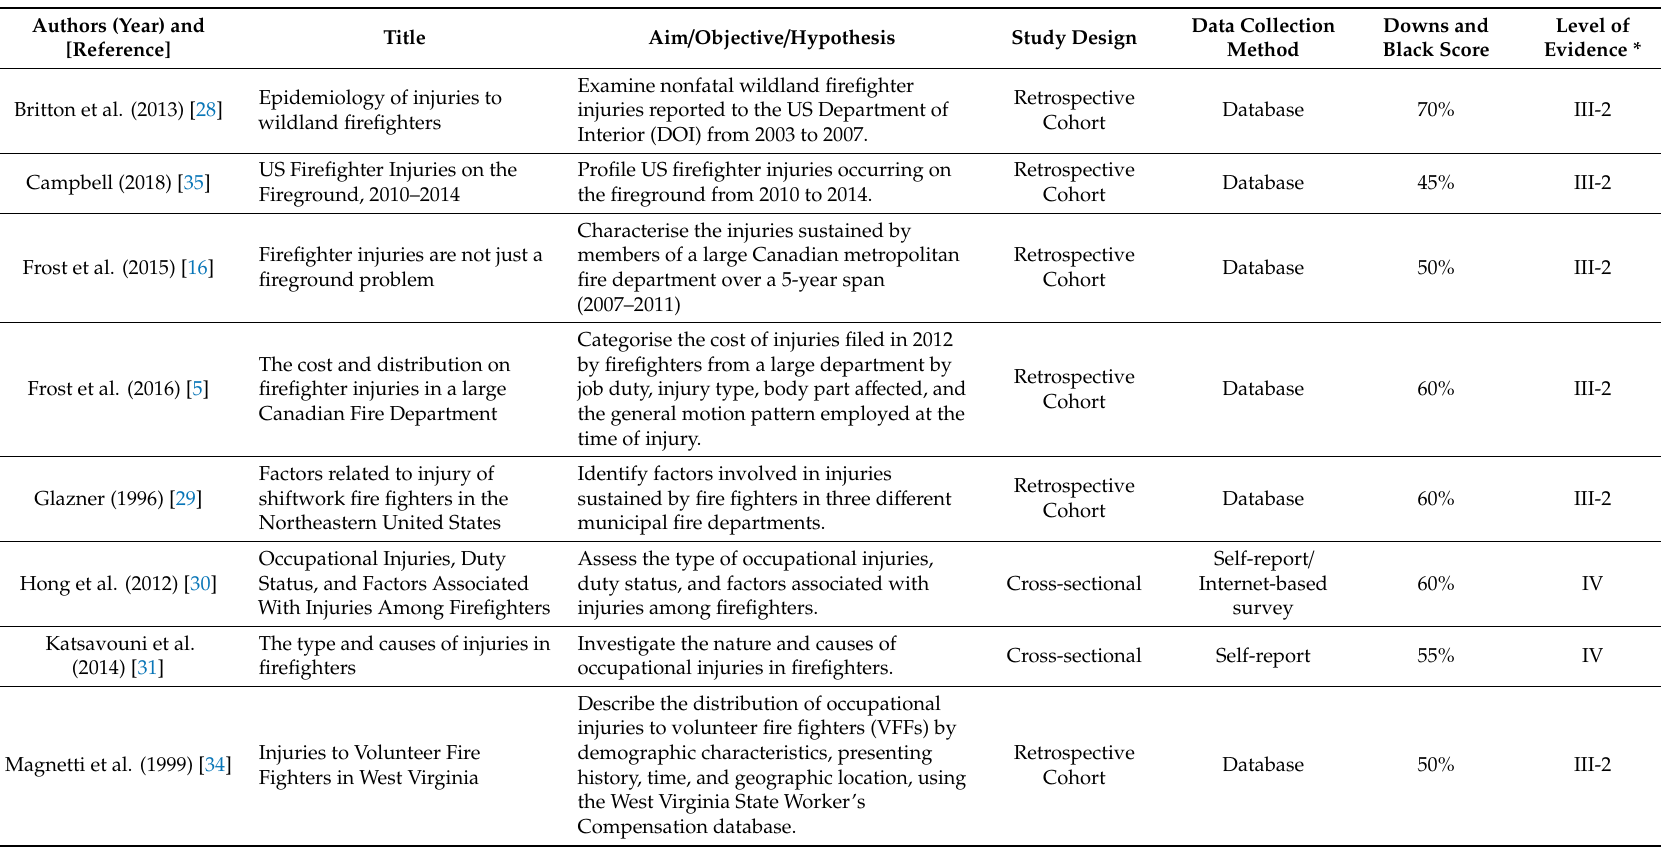
Table 4. Key information regarding the design, aims, data sources, critical appraisal score and levels of evidence of each included study. Authors (Year) and